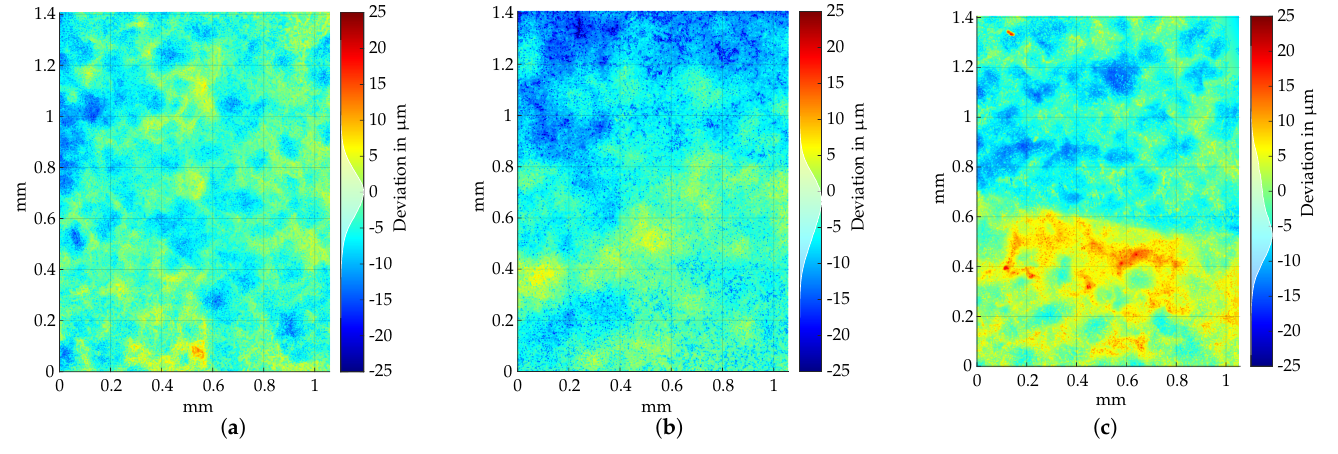
Figure 16. Examination of the surface using a confocal laser scanning microscope. ( a ) Disassembly force 50kN. ( b ) Disassembly force 60kN. ( c ) Disassembly force